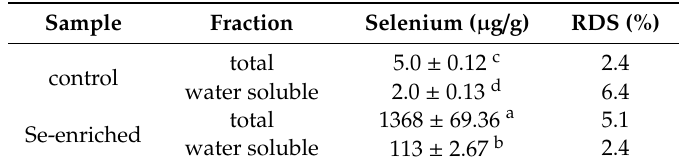
Table 2. Total selenium determination and speciation in Candida